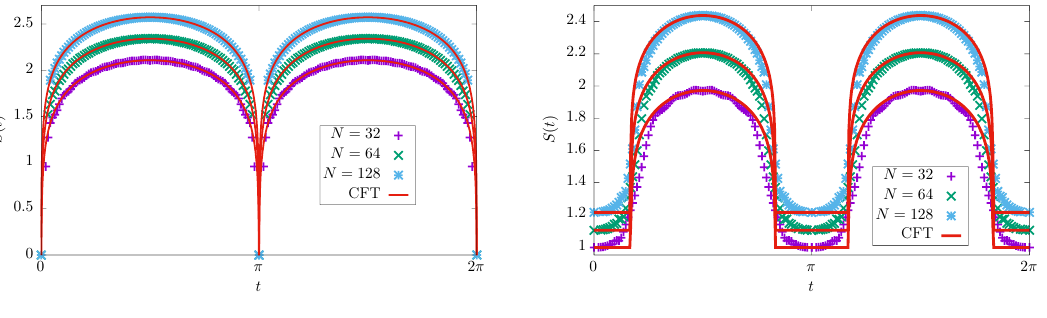
Figure 5: Entanglement entropy as a function of time after a cut and glue quench in the harmonic trap. Left: measure in the middle, x = 0. As can be seen the agreement between the microsopic calculation and the CFT result is excellent. The agreement even improves for a larger number of particles. Right: measure at x = (cid:96)/ 2, for a trap x ∈ [ − (cid:96) , (cid:96) ] . The agreement is very good, but there are, as discussed in the text, small but noticeable